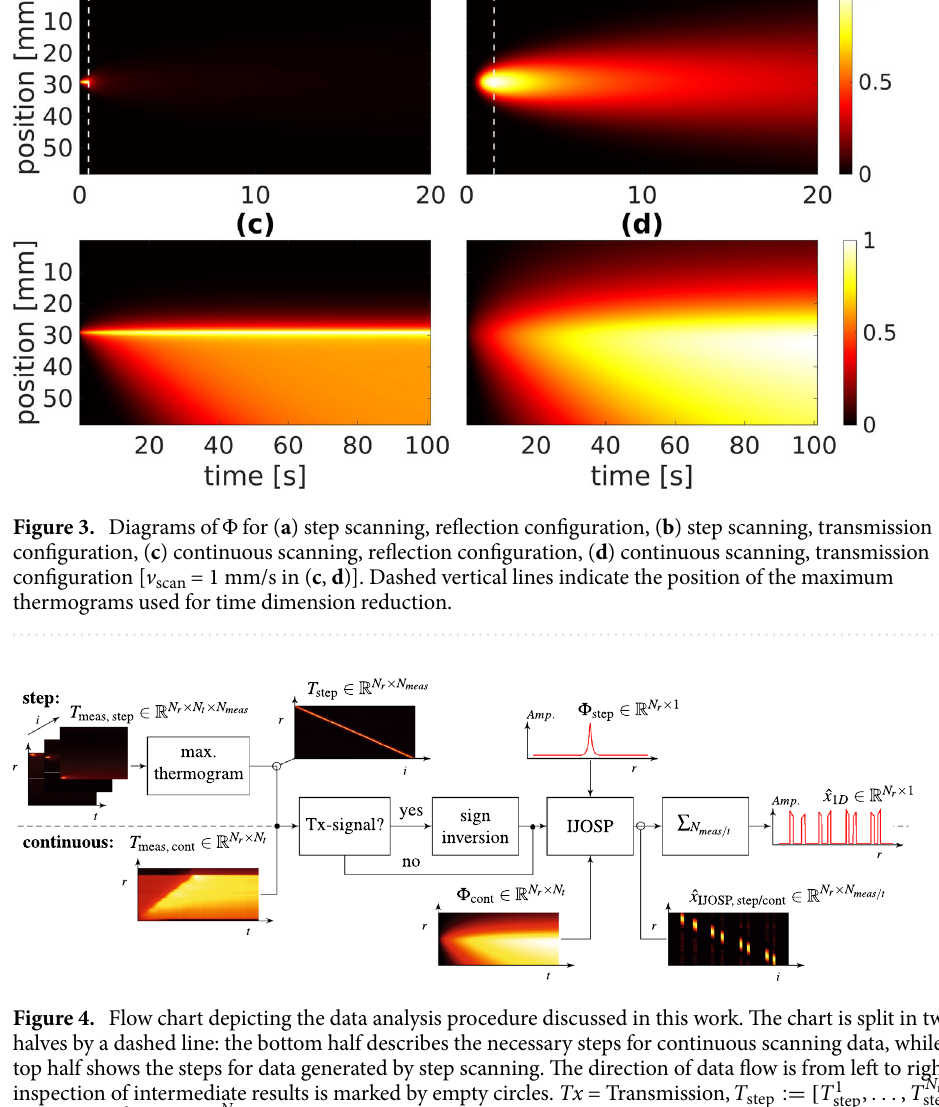
N meas T 1 , . . . , T step ] , step := [